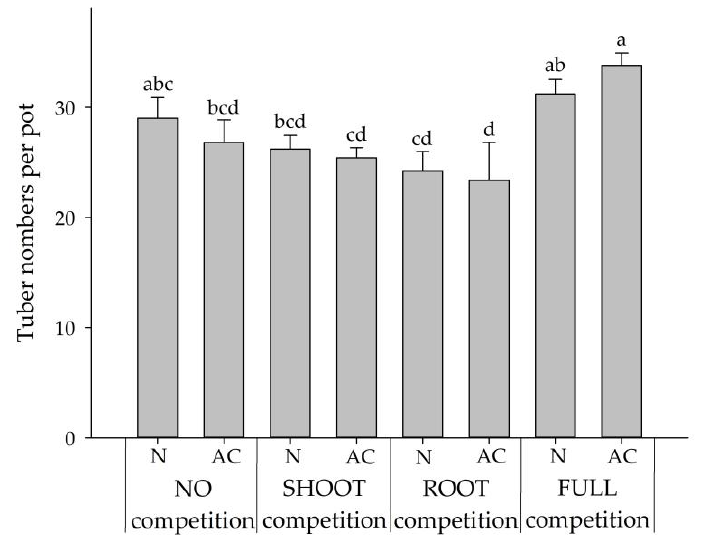
Figure 4. Tuber numbers per pot of CR when grown with two activated carbon application treatments and subjected to four competition modes with BPr . AC and N denoted pots with and without activated carbon application, respectively. Error bars are the standard error of mean ( n = 5). Means with the same letter(s) are not significantly di ff erent at 5% level by LSD test. Data were square-root transformed prior to analysis.